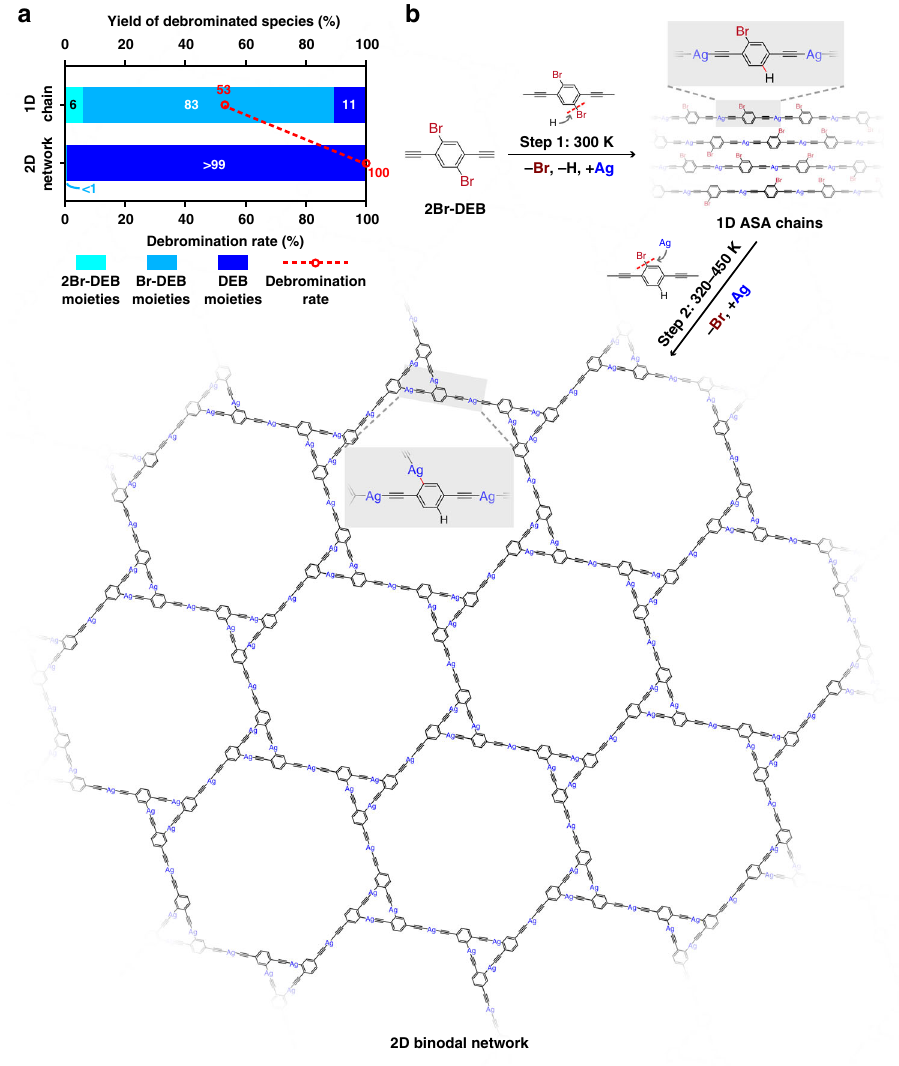
Fig. 4 Stepwise activation of Br-substituents and dissymmetric reaction of 2Br-DEB. a Statistical results of the debromination yield and debromination rate in the 1D chains and 2D networks. b Schematic illustration of stepwise activation and dissymmetric reaction of 2Br-DEB on